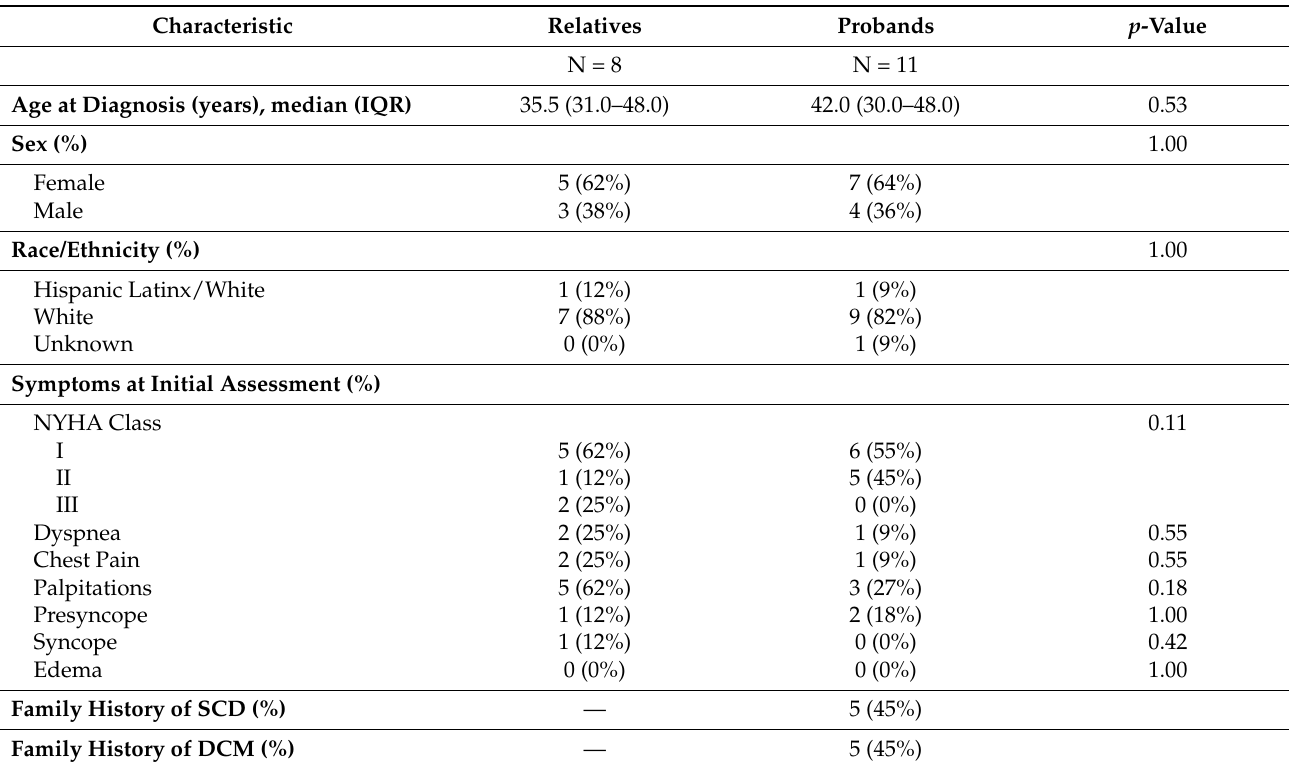
Table 1. Demographics and clinical characteristics of 19 probands and relatives with pathogenic or likely pathogenic variants in the desmoplakin gene ( DSP ). Abbreviations: NYHA = New York Heart Association; SCD = sudden cardiac death; DCM = dilated